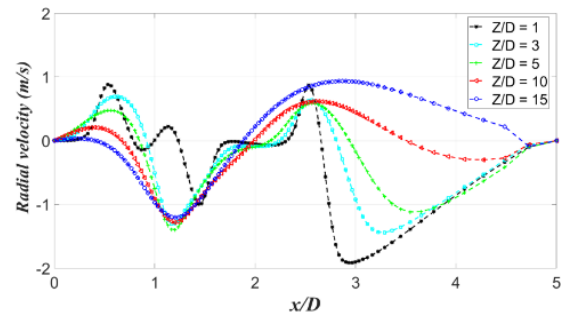
Figure 8. Radial velocity distributions at different streamwise locations.